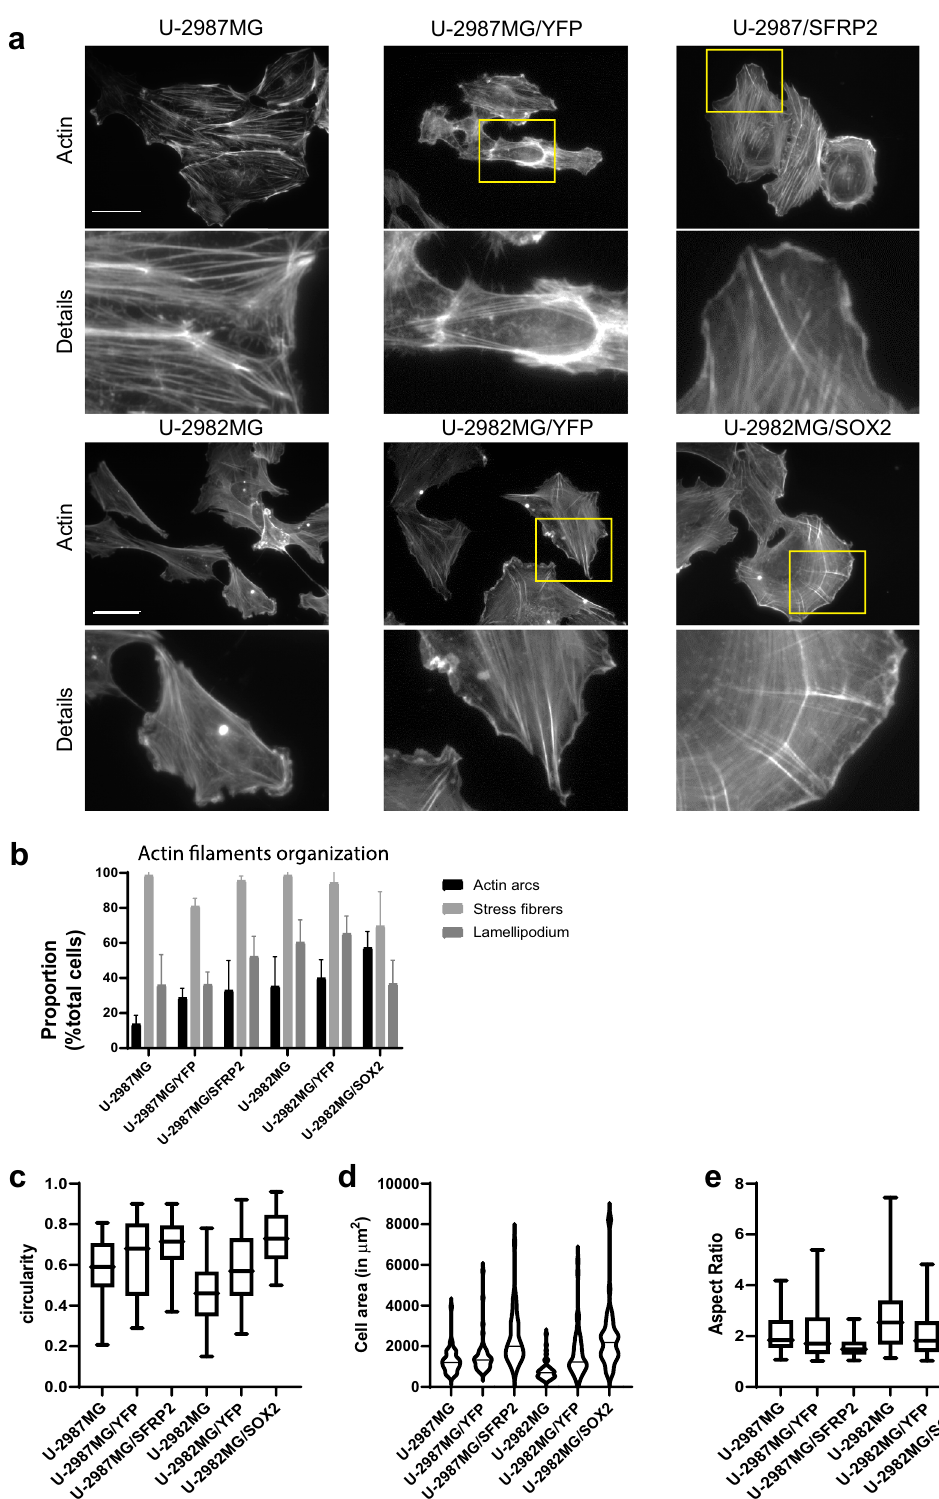
Figure 4. Actin filament organization and cell morphology in cell lines U-2982MG/SOX2 and U-2987MG/ SFRP2. ( a ) Representative images of actin filament organization, visualized using TRITC-conjugated phalloidin. Scale bar, 50 µm. ( b ) Analysis of the type of actin organization in each cell line. Quantification was performed from three independent experiment in at least 150 cells per cell line. Statistical significance was calculated